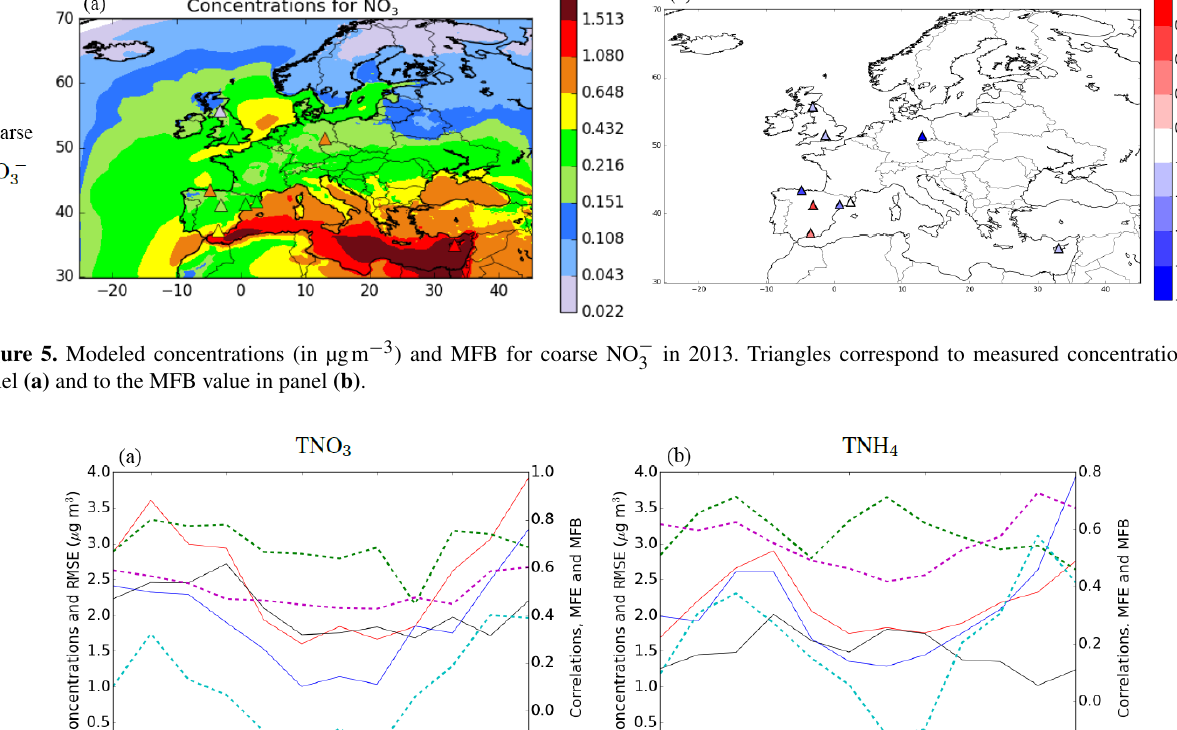
Figure 6. Seasonal evolution of statistics for the all Europe for TNO 3 and TNH 4 : monthly mean measured concentrations (black), monthly mean modeled concentrations (red), monthly RMSEs (blue), monthly spatiotemporal correlations (green), monthly MFB (cyan) and monthly MFE (magenta).